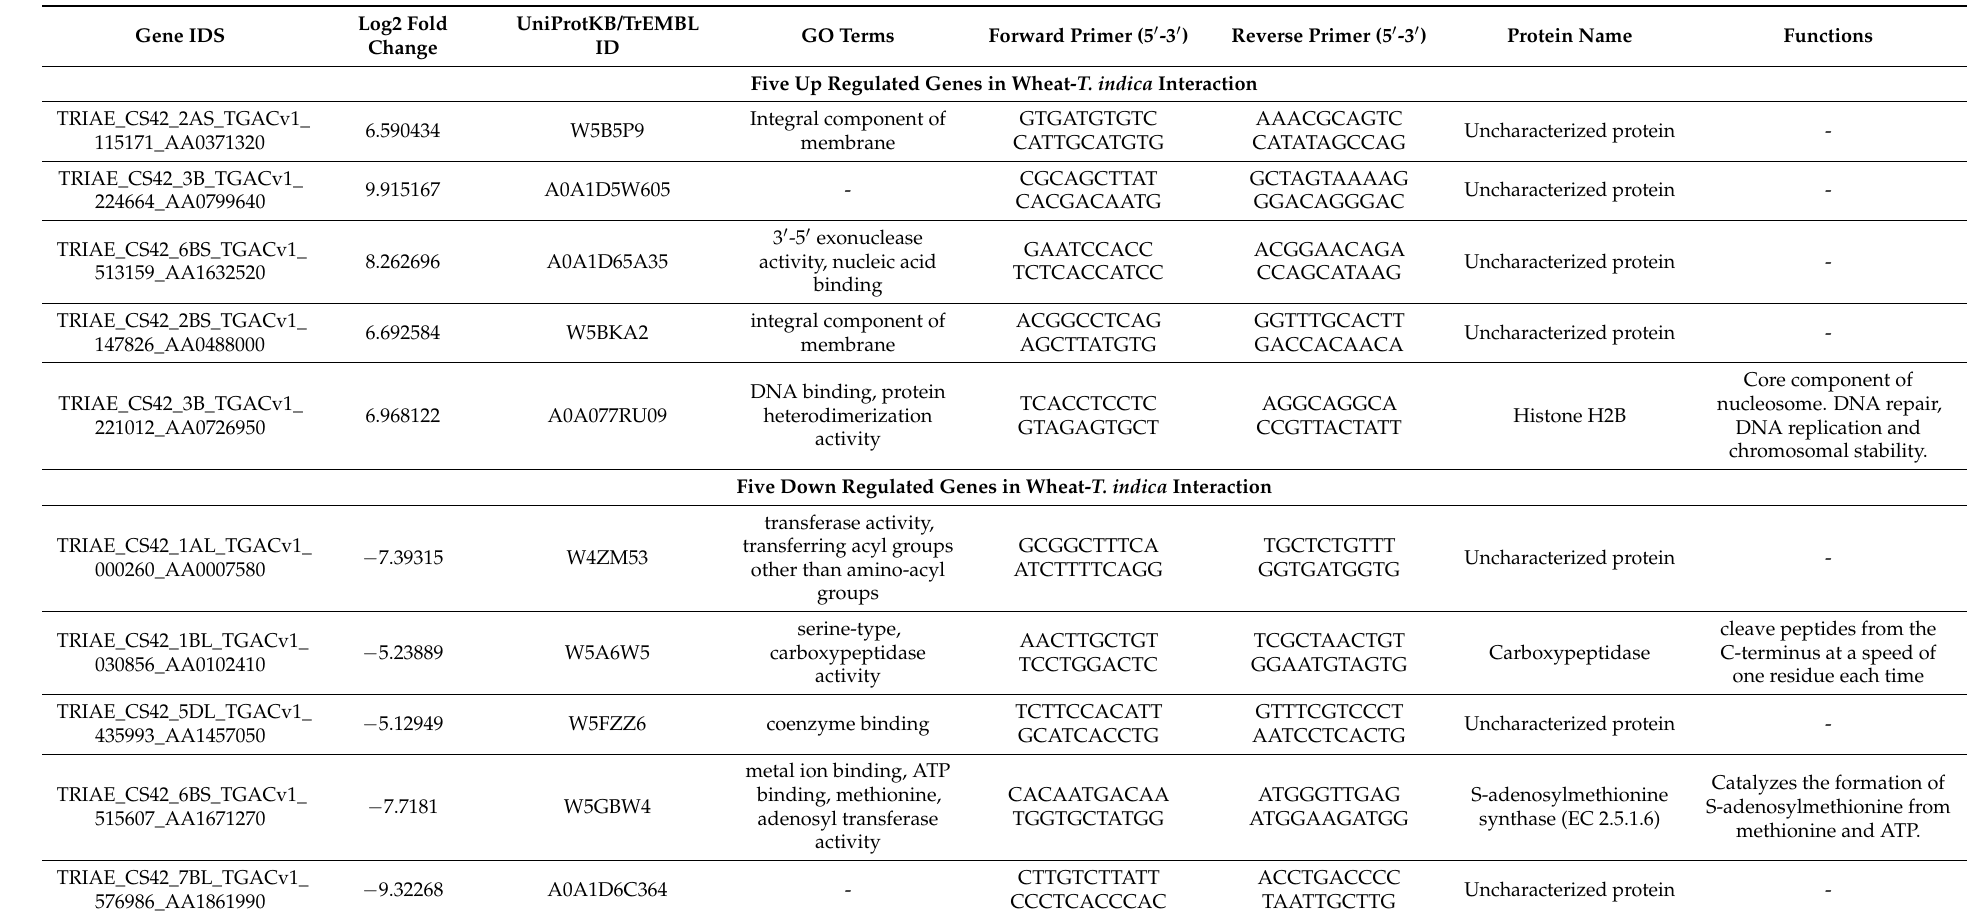
Table 5. List of differentially expressed genes used for expression